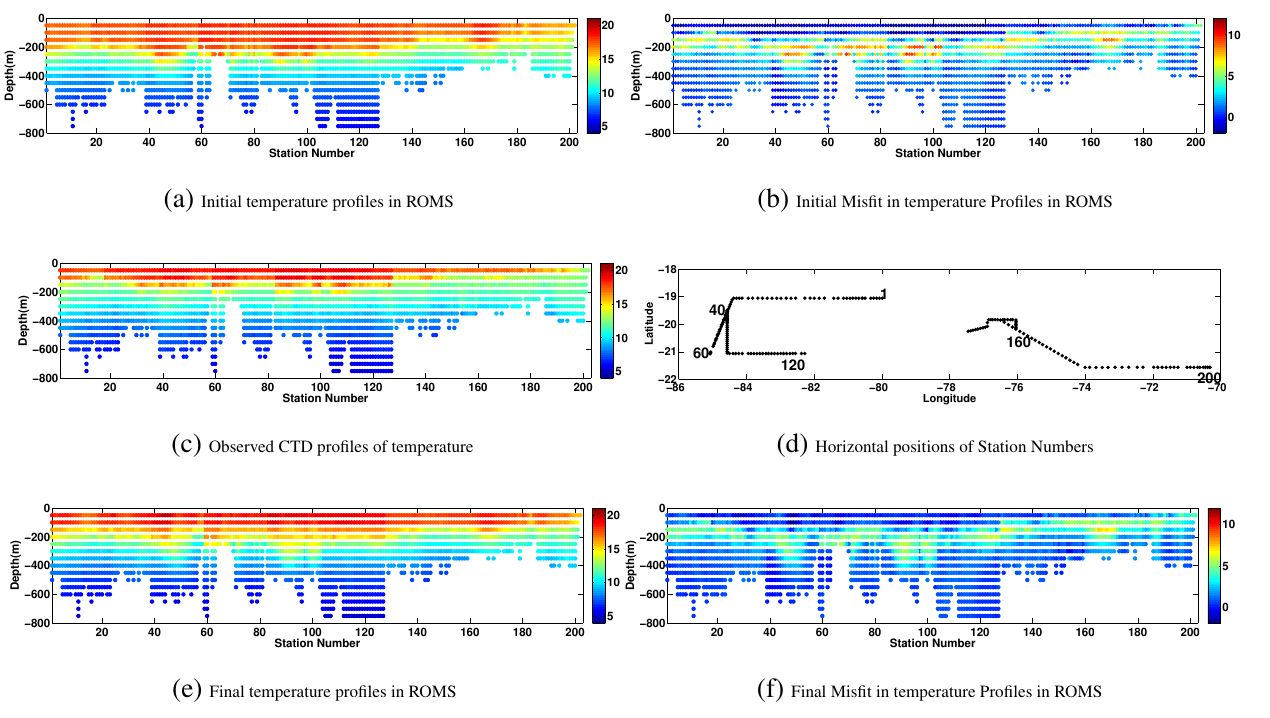
Fig. 6. (a, e) Model temperature profile values (in ◦ C) before and after assimilation. (c) shows the observed temperature profiles in the same location. The horizontal location of the profiles are shown in (d) which are the same as in the second leg shown in Fig. 1. The initial model misfit before assimilation (d) and the final model misfit after assimilation (f) for the second 15 day fit from 16 to 30 November 2008 is shown